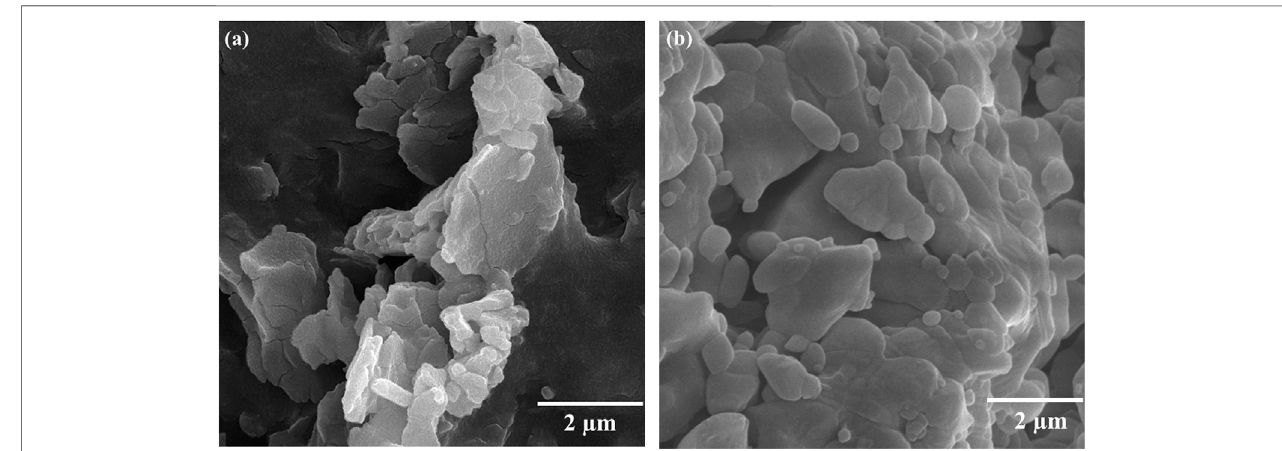
FIGURE 4 | The FE-SEM image of Al-MOF with CA and Na 2 -CA, (A) S1 and (B) S2, respectively.